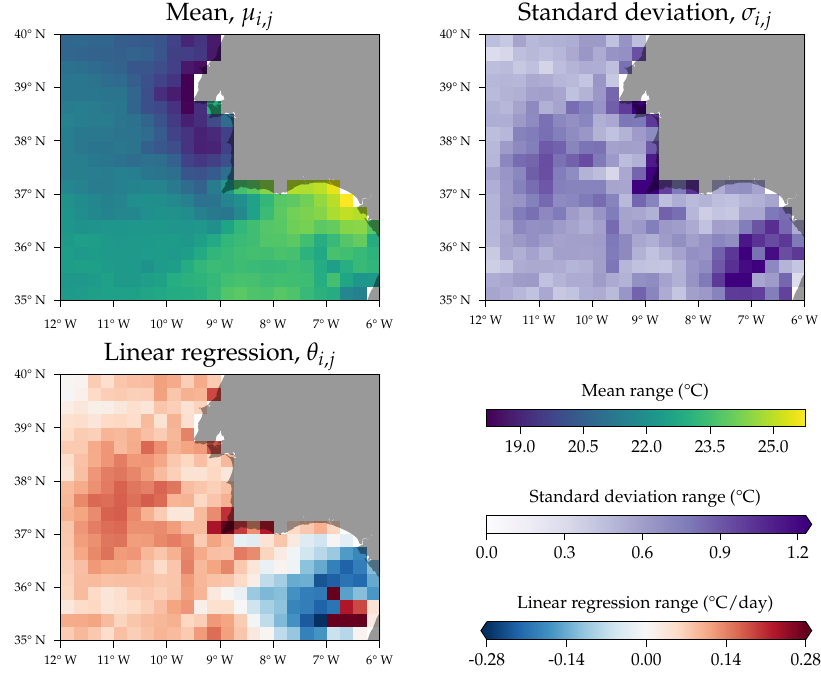
Figure 4. Computed statistics for the period between 30 July and 13 August 2016.